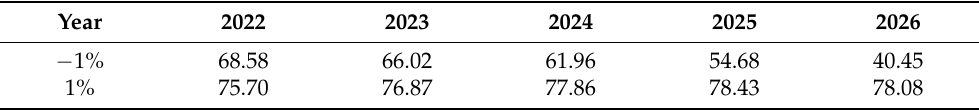
Table 23. Prediction result of water requirement with different growth rates of YEP in Shanxi